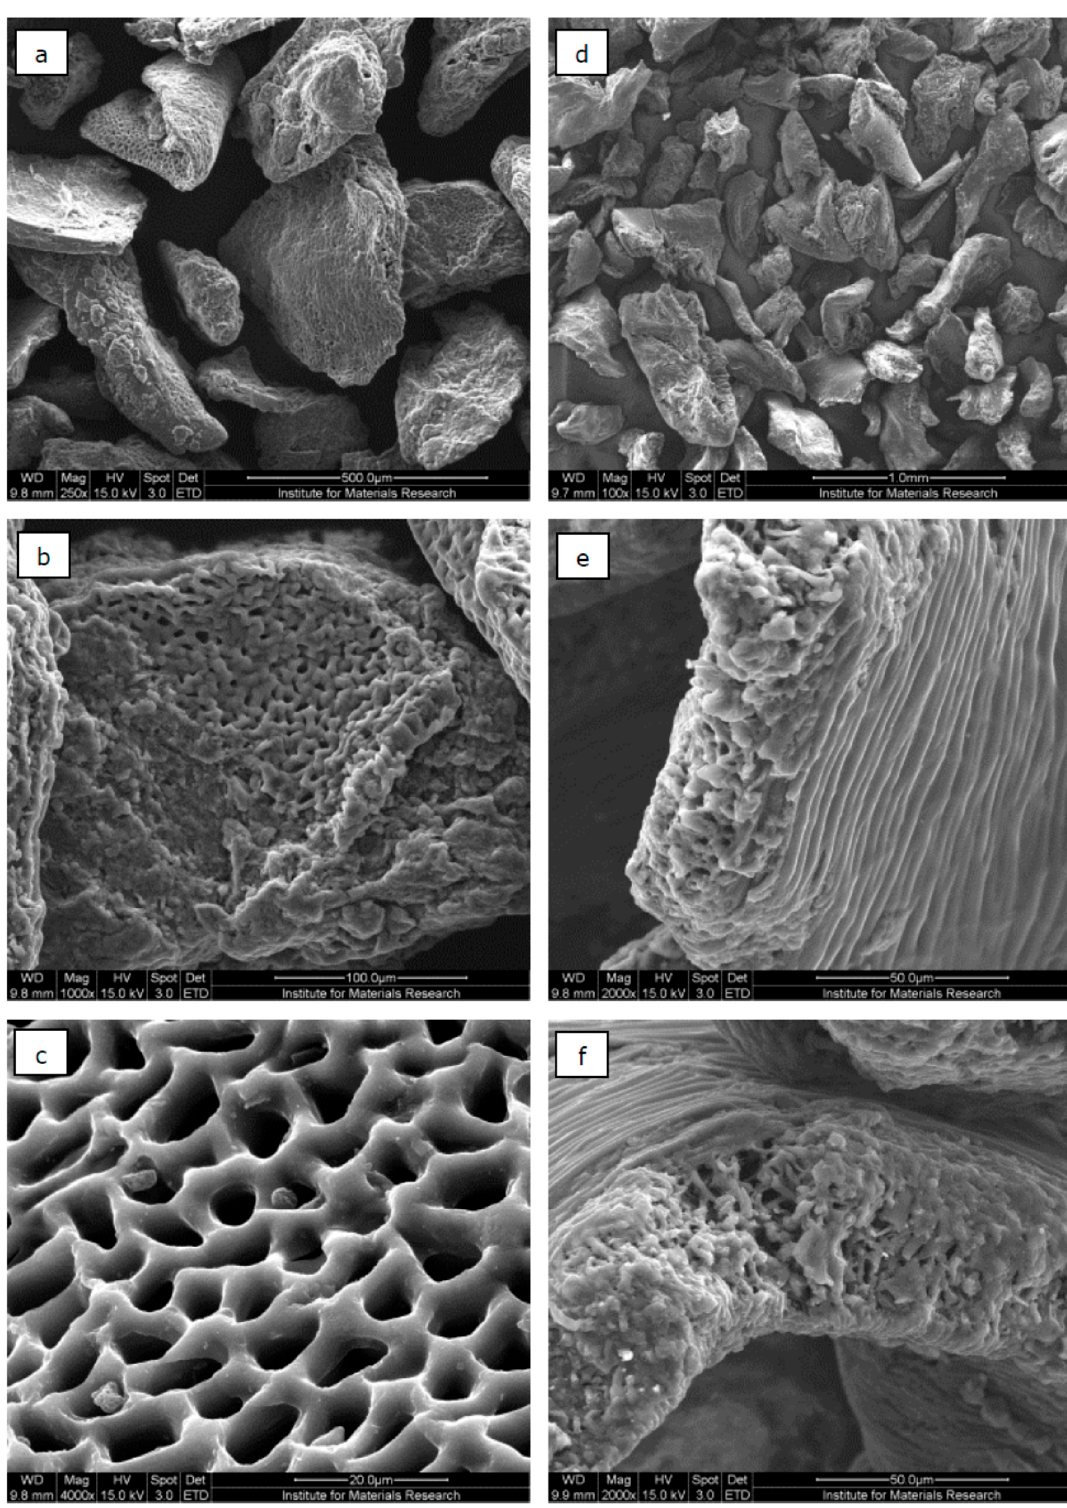
Figure 4. SEM images of ACs produced from rapeseed cake (C-900-60) with a magnification factor of 250 ( a ), 1000 ( b ) and 4000 ( c ); and ACs produced from raspberry seed cake (C-950-30) with a magnification factor of 100 ( d ), 2000 ( e ) and 4000 ( f ).